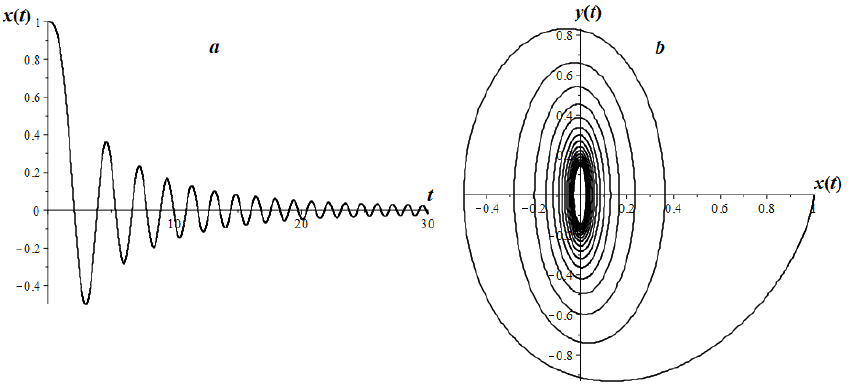
Figure 22. The classic Airy oscillator with friction: ( a ) oscillogram; ( b ) phase